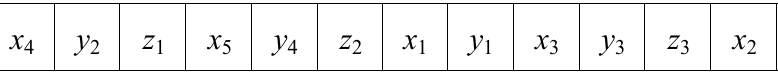
Figure 2. Individual coding mode.